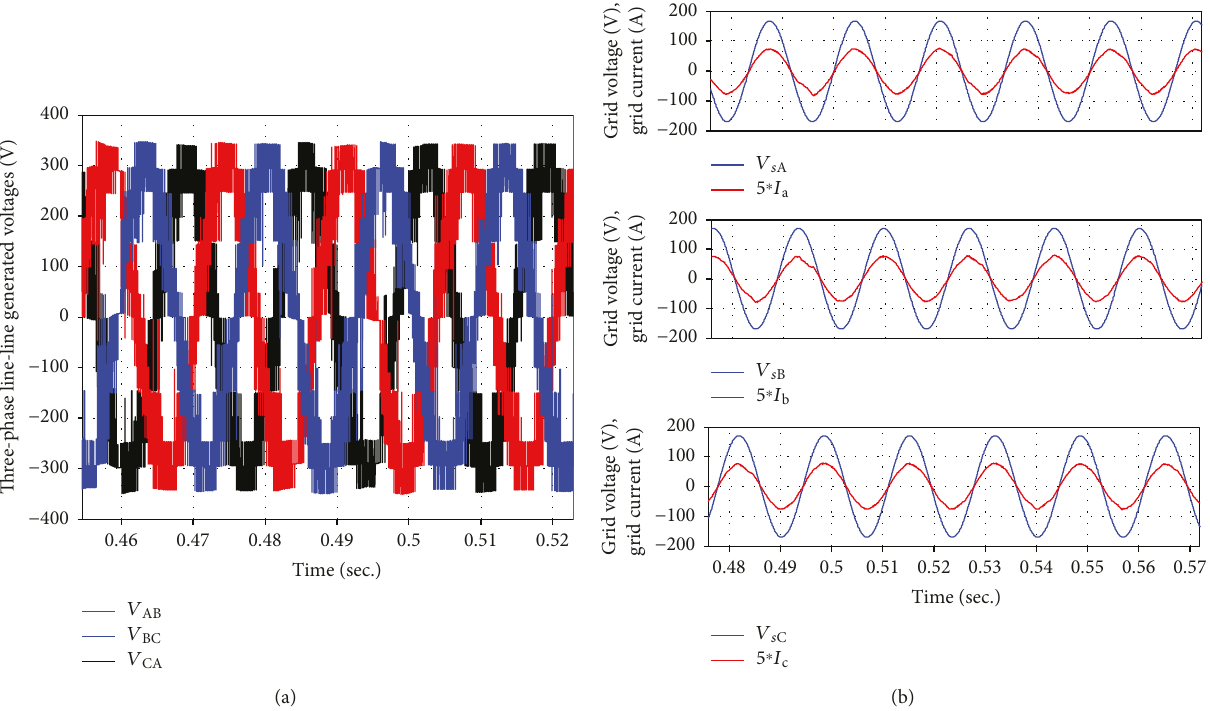
Figure 8: (a) Simulation results of three-phase voltage generated from con fi guration B. (b) Simulation results of grid voltages and grid currents of con fi guration